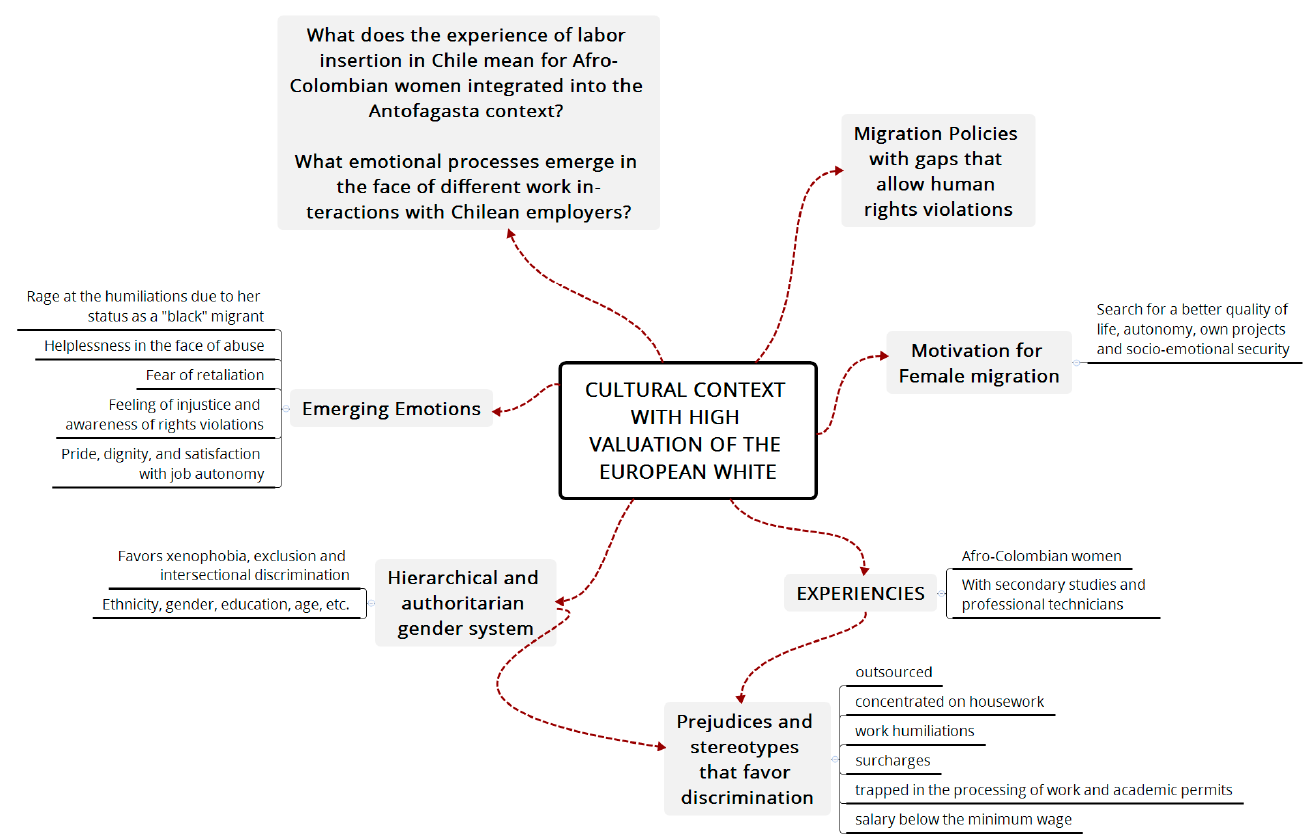
Figure 4. Emerging Analysis Model. Source: Own elaboration.